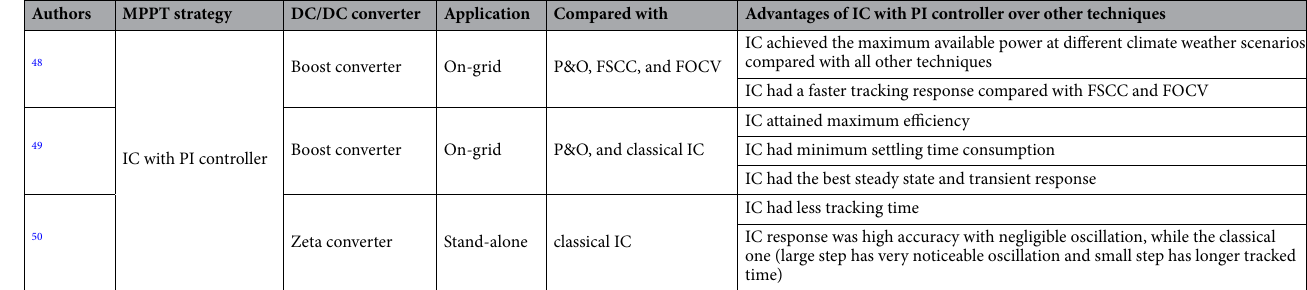
Table 1. Comparison of Various MPPT Methods against IC with a PI